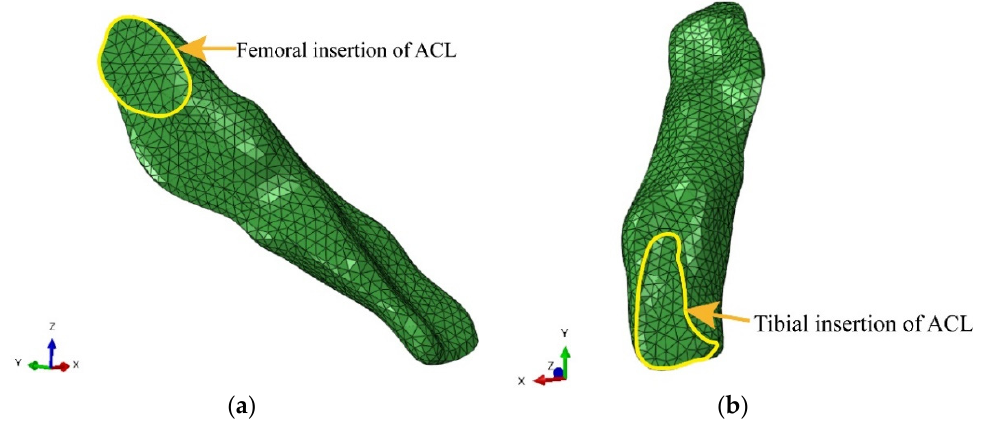
Figure 3. The morphology of the femoral and tibial insertions in the ACL: ( a ) The outline of the red mark indicates the femoral insertion of the ACL; ( b ) The outline of the red mark indicates the tibial insertion of the ACL.